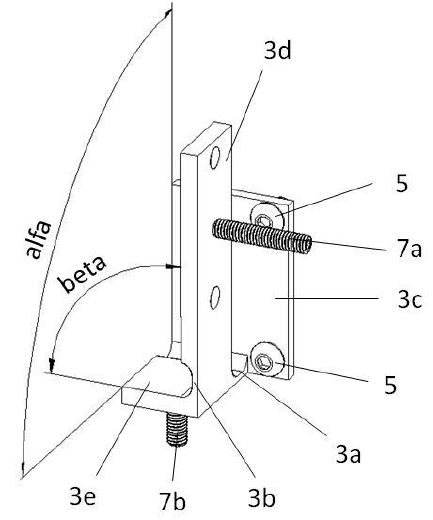
Figure 10. Compliant fixture: 3a and 3b—constriction; 3c and 3d—mounting wall; 3e—working wall; 5—clamping screws; 7a and 7b—aligning screws.